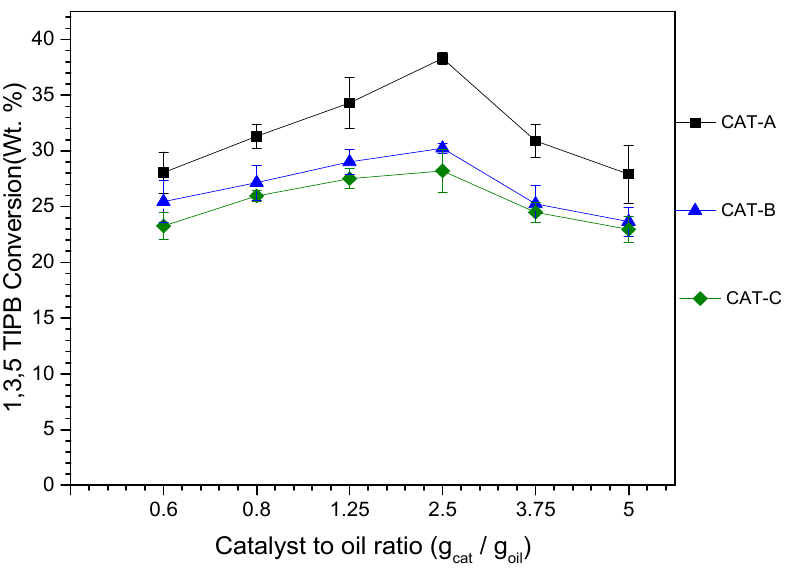
Figure 7. Changes of the 1,3,5 -TIPB Conversion with the C/O ratio in the CREC riser simulator for CAT-A, CAT-B, and CAT-C. Note: Reaction time: 7 s, temperature: 550 °C. Reported data and standard deviations (vertical bars) represent at least five repeats.